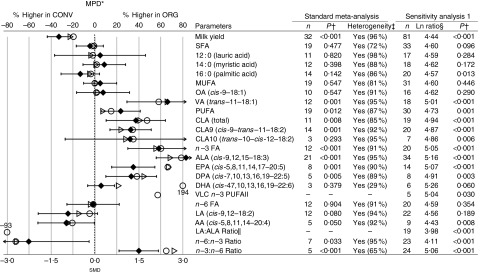
Results of the standard meta-analyses and sensitivity analysis 1 for fat
composition in cows’ milk. * Numerical values for mean percentage difference (MPD)
and 95 % CI are given in the online Supplementary Table S9. † Significantly
different between organic samples (ORG) and conventional samples (CONV)
(P<0·05). ‡ Heterogeneity and the I
2 statistic. § Ln ratio=Ln(ORG/CONV×100 %). || Calculated based on
published fatty acid (FA) composition data. , MPD calculated using
data included in sensitivity analysis 1; , MPD calculated using
data included in standard meta-analysis; , standardised mean
difference (smd) from the standard meta-analysis with 95 % CI represented
by horizontal bars. n, number of data points included in
meta-analyses; OA, oleic acid; VA, vaccenic acid; CLA, conjugated linoleic acid;
ALA, α-linolenic acid; VLC n-3 PUFA, very
long-chain n-3 PUFA (EPA+DPA+DHA); LA, linoleic acid; AA,
arachidonic acid.